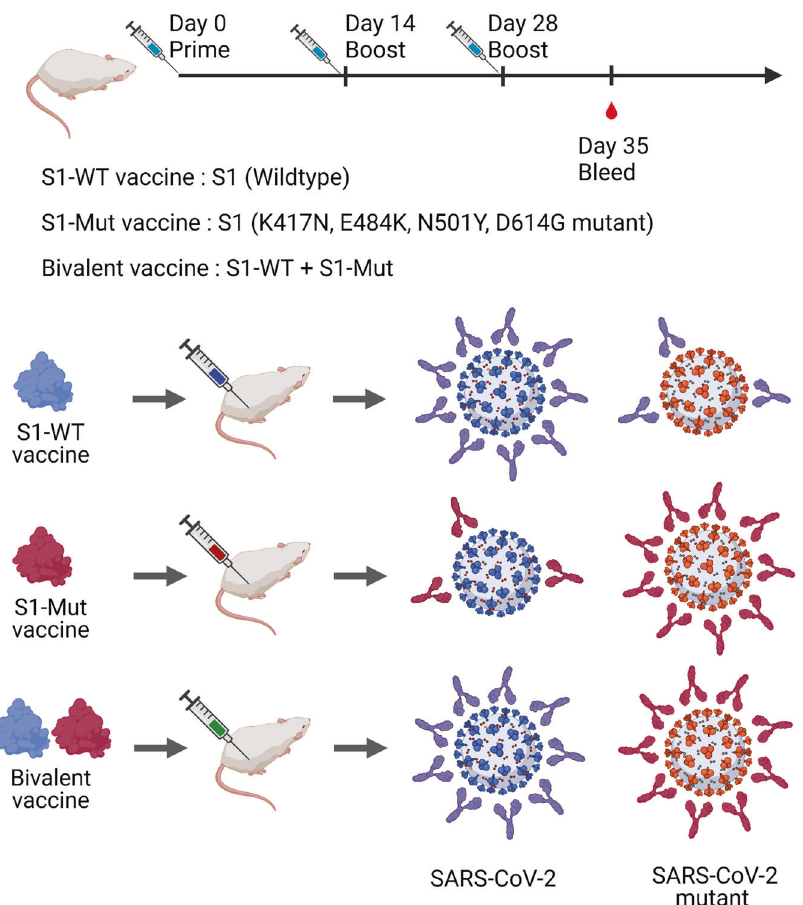
Fig. 1 The diagram of monovalent recombinant S1-WT and S1-Mut protein vaccine and the combined bivalent vaccine against SARS-CoV-2 and mutant strains. The ICR-hACE2 mice were immunized with recombinant S1-WT/S1-Mut protein vaccine and bivalent vaccine by intramuscular injection on days 0, 14, and 28, separately. The S1-WT vaccine induced higher neutralizing antibodies against wild-type of SARS- CoV-2 than that of variants while S1-Mut vaccine stimulated higher neutralizing antibodies against SARS-CoV-2 variants. The bivalent recombinant vaccine composed of S1-WT and S1-Mut could induce the neutralizing antibodies against both SARS-CoV-2 variants and wild- type of the virus, indicating a potential and effective approach for the development of universal coronavirus